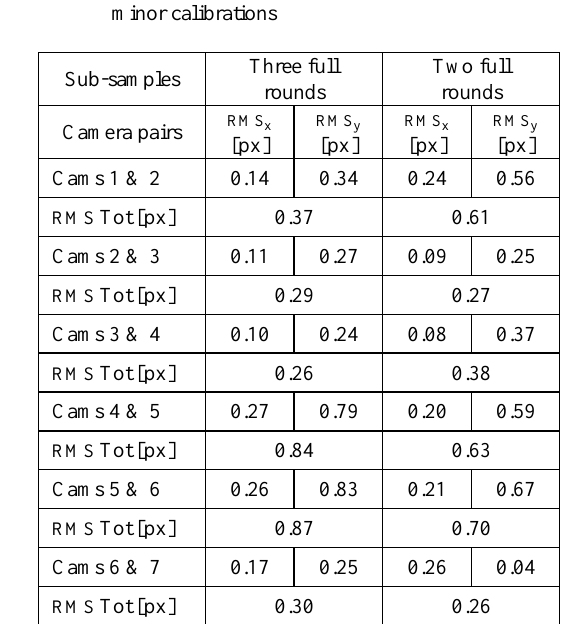
Table 5. Minor calibration results from the system stability analysis comparing the three and two full round sub- sampled minor calibration data sets with the full